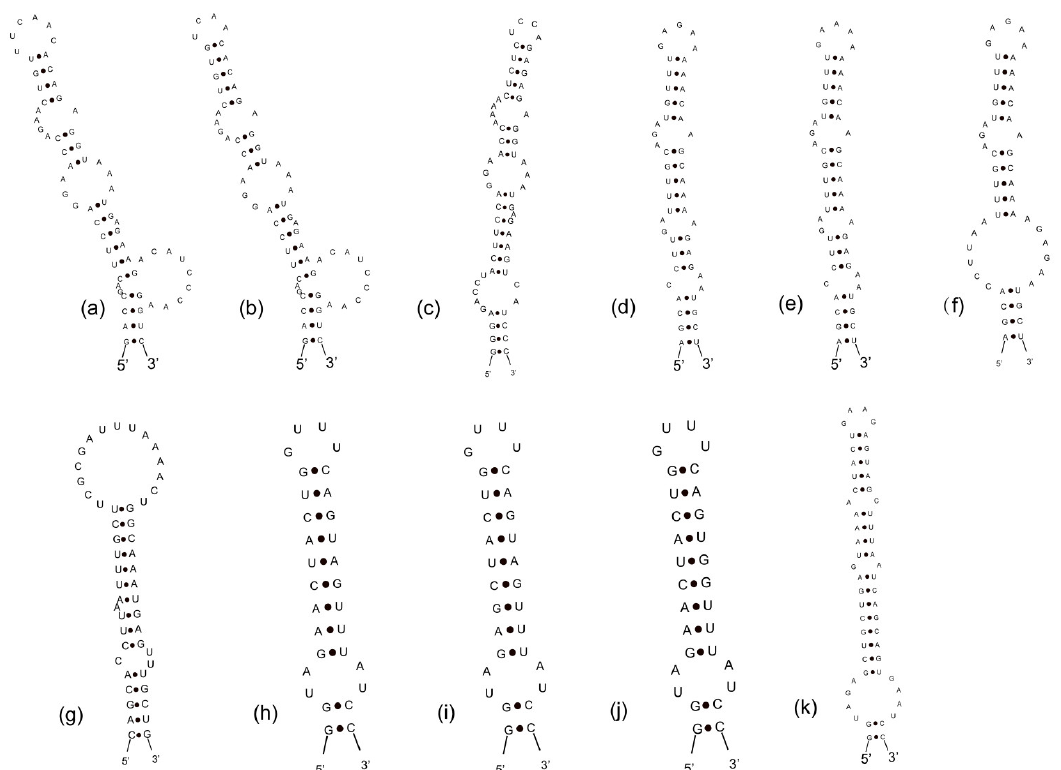
Figure 9. D1–D1’ helix of Potamolinea aerugineocaerulea : ( a ) Potamolinea aerugineocaerulea 1PC, 2PC; ( b ) Potamolinea aerugineocaerulea 38PC; ( c ) Potamolinea aerugineocaerulea WZU strains. Box–B helix of Potamolinea aerugineocaerulea : ( d ) Potamolinea aerugineocaerulea 1PC; ( e ) Potamolinea aerugineocaerulea 2PC; ( f ) Potamolinea aerugineocaerulea 38PC; ( g ) Potamolinea aerugineocaerulea WZU strains. V3 helix of Potamolinea aerugineocaerulea : ( h ) Potamolinea aerugineocaerulea 1PC; ( i ) Potamolinea aerugineocaerulea 2PC; ( j ) Potamolinea aerugineocaerulea 38PC; ( k ) Potamolinea aerugineocaerulea WZU